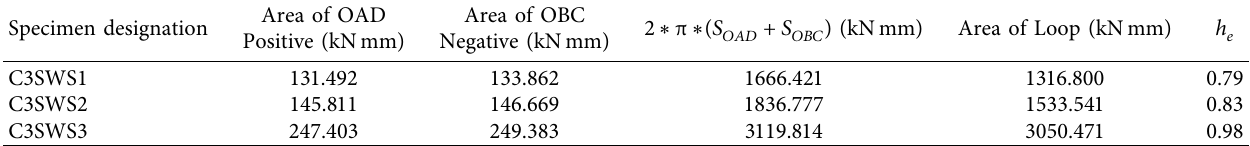
Table 7: Cumulative energy dissipation and viscous damping ratio of 135 ° -type connection.